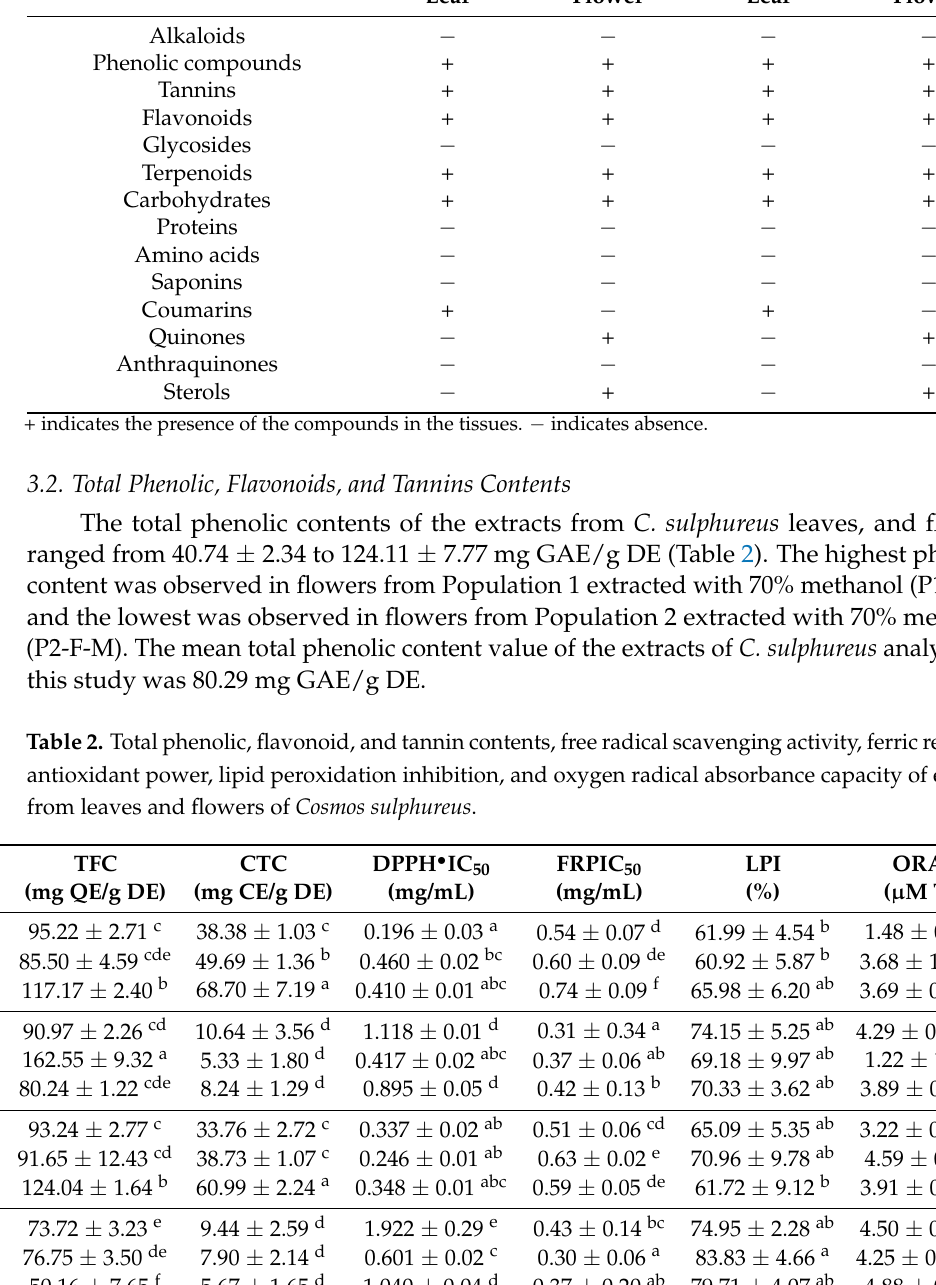
Table 1. Results of the qualitative phytochemical analysis of ethanolic and methanolic leaf and flower extracts from three populations of C. sulphureus . 70% Ethanol Extracts 70% Methanol Extracts Phytochemical Constituents Leaf Flower Leaf Flower Alkaloids − − − − Phenolic compounds + + + + Tannins + + + + Flavonoids +